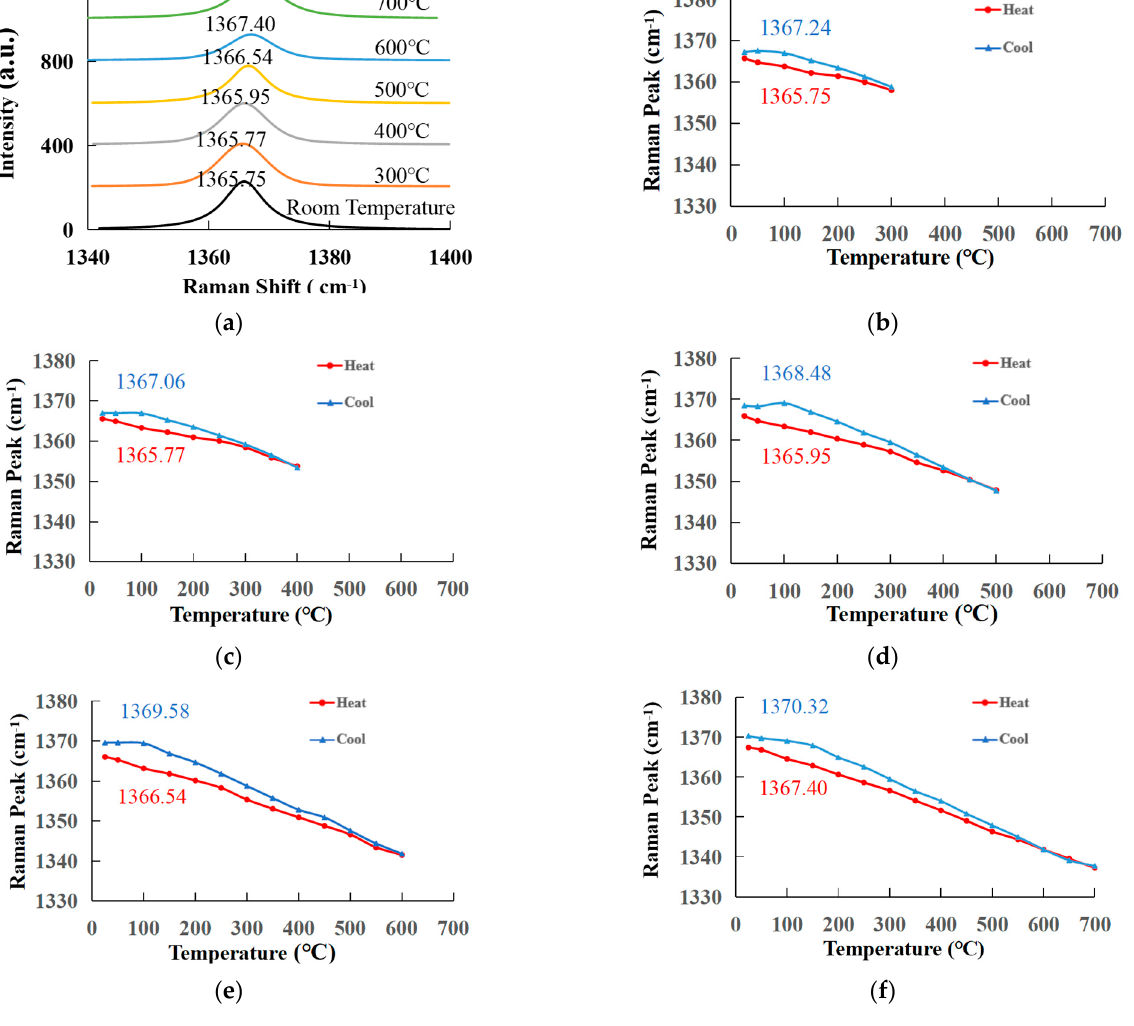
Figure 10. Ex situ and in situ Raman spectra: ( a ) Ex situ Raman spectra of the h-BN flake shown in Figure 2. Raman peak frequency shifts during heating/cooling cycle under the annealing temperatures of 300 °C ( b ), 400 °C ( c ), 500 °C ( d ), 600 °C ( e ) and 700 °C ( f ). The red and blue numbers in Figure 10 represent the Raman peak frequency at room temperature before and after annealing. The differences between the two values